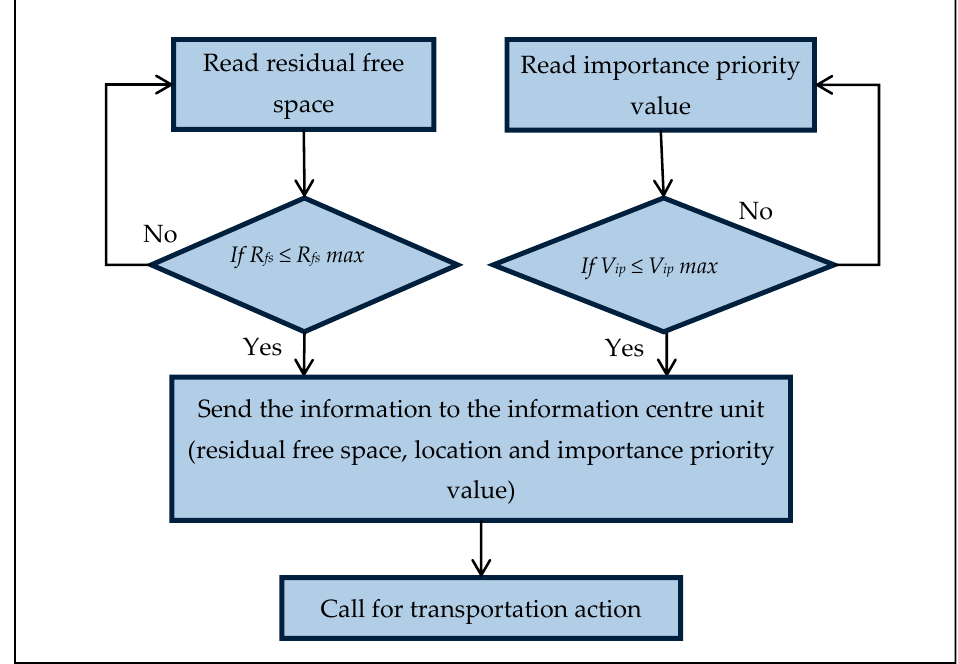
Figure 7. Intelligent bin handling information.